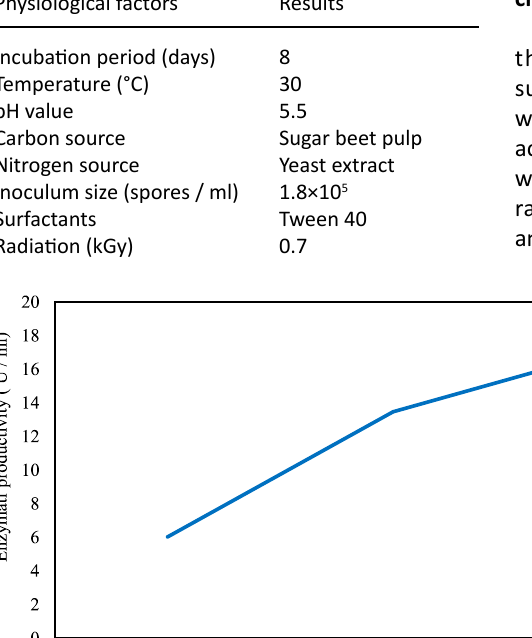
Table 4. Summary of the optimum conditions for the xylanase production Physiological